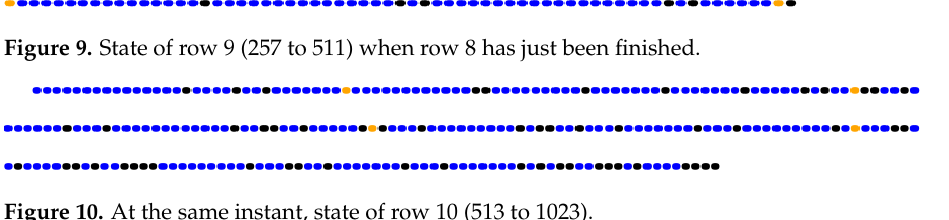
Figure 8. State of row 8 (129 to 255) when it has just been finished.